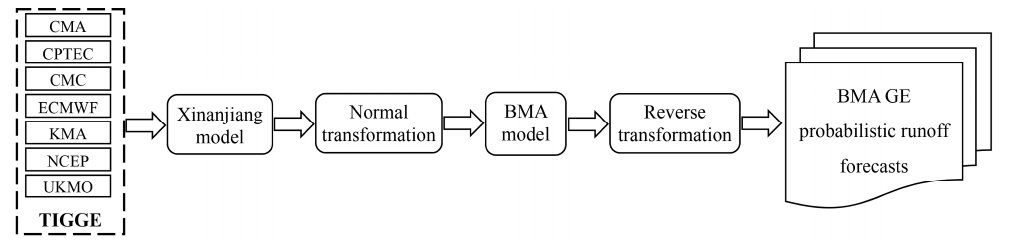
Figure 2. The flow chart of the BMA GE probabilistic runoff forecasting system in the Fu River basin, showing a cascade of components. Note that this is not a standardized technological procedure, and some components may need to be modified/removed for other experiments.